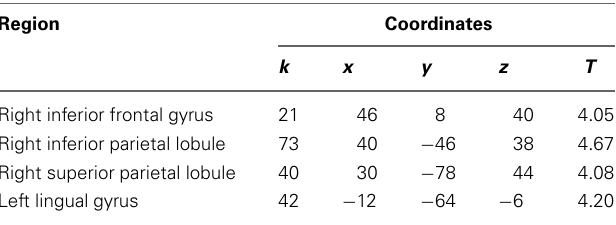
Table 2 | Coordinates and peak activation statistics for clusters in in-group—out-group contrast, predicted by